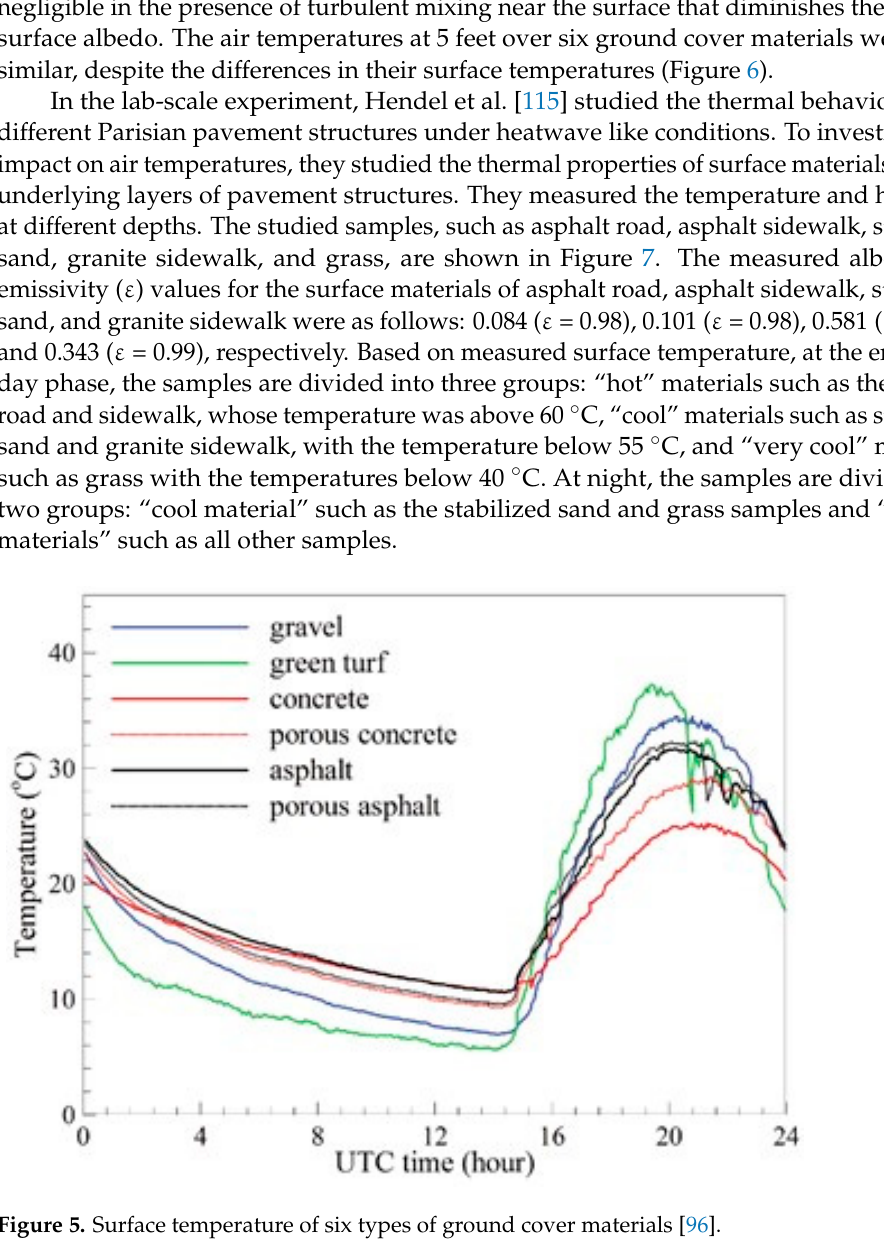
Figure 6. Air temperature at 5 feet over six ground cover materials [96]. In the lab-scale experiment, Hendel et al. [115] studied the thermal behavior of five different Parisian pavement structures under heatwave like conditions. To investigate the impact on air temperatures, they studied the thermal properties of surface materials and the underlying layers of pavement structures. They measured the temperature and heat flow at different depths. The studied samples, such as asphalt road, asphalt sidewalk, sta- bilized sand, granite sidewalk, and grass, are shown in Figure 7. The measured albedo and emissivity ( ε ) values for the surface materials of asphalt road, asphalt sidewalk, sta- bilized sand, and granite sidewalk were as follows: 0.084 ( ε = 0.98), 0.101 ( ε = 0.98), 0.581 ( ε = 0.92), and 0.343 ( ε = 0.99), respectively. Based on measured surface temperature, at the end of the day phase, the samples are divided into three groups: “hot” materials such as the asphalt road and sidewalk, whose temperature was above 60 °C, “cool” materials such as stabilized sand and granite sidewalk, with the temperature below 55 °C, and “very cool” materials such as grass with the temperatures below 40 °C. At night, the samples are divided into two groups: “cool material” such as the stabilized sand and grass samples and “warmer materials” such as all other samples.